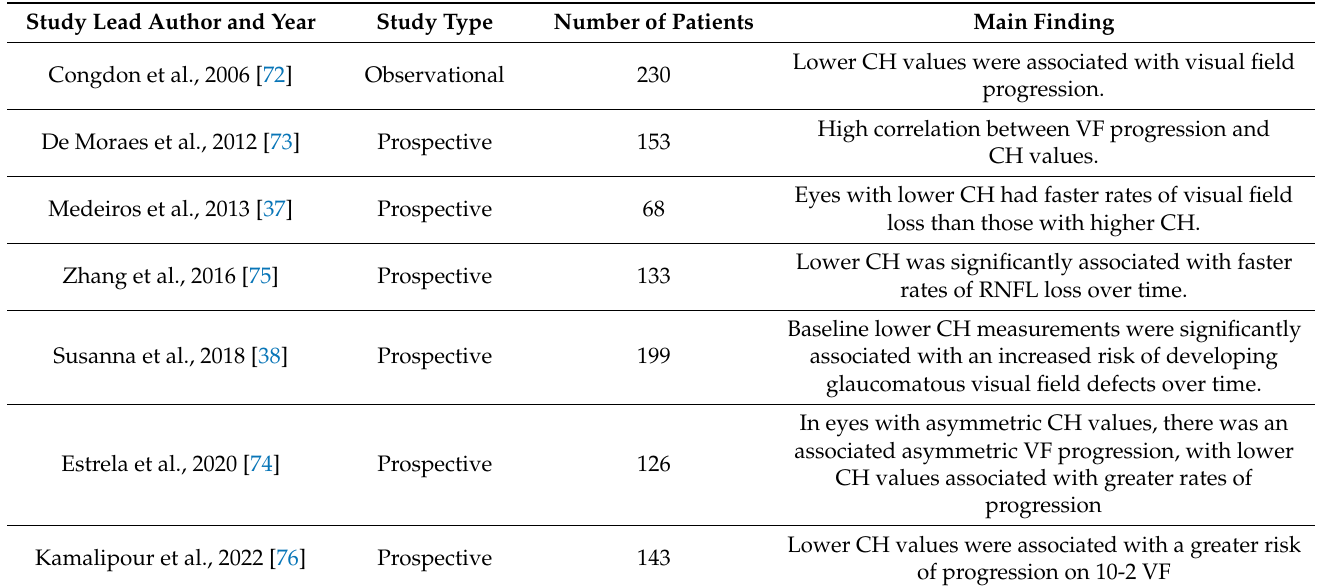
Table 2. Summary of main findings of CH studies in terms of glaucoma